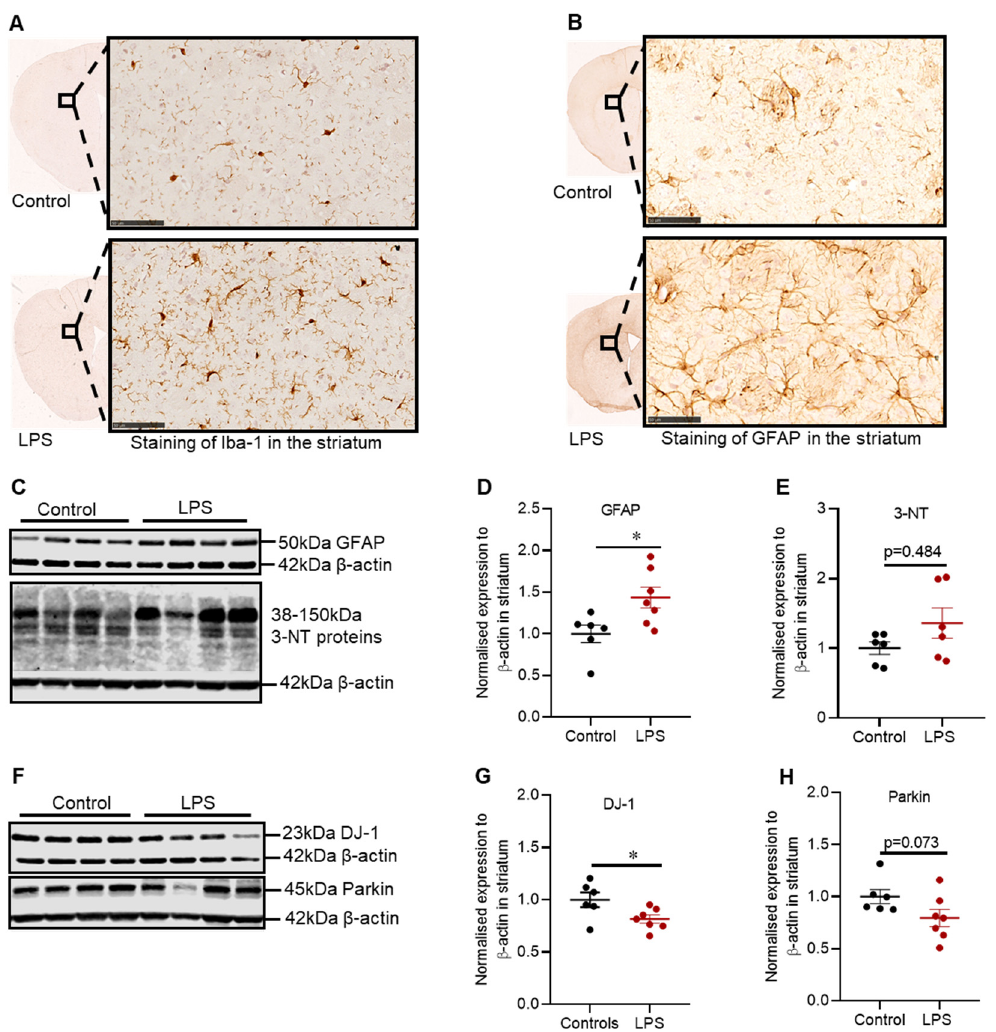
Figure 3. LPS altered the inflammatory and oxidative stress markers, and proteins involved in defence mechanisms against oxidative stress in the striatum of C57BL/6 mice. Representative images for immunohistochemical detection of Iba-1( A ) and GFAP( B ) in the striatum. ( C ) Representative immunoblots for GFAP and 3-NT proteins in the striatum. ( D ) Densitometric analysis of GFAP protein. ( E ) Densitometric analysis of 3-NT proteins. ( F ) representative immunoblots for DJ-1 and Parkin in the striatum (involved in defence against oxidative stress). ( G ) Densitometric analysis of DJ-1 protein. ( H ) Densitometric analysis of parkin protein. The results are presented as mean ± SEM (control n = 6; LPS n = 6–7). Statistical analysis was performed with a Mann–Whitney test, p < 0.05 (*). Immunohistochemical detection of Iba-1 and GFAP (scale bar: 50 µm; microscopic magnification: X400) (control n = 5; LPS n = 5).